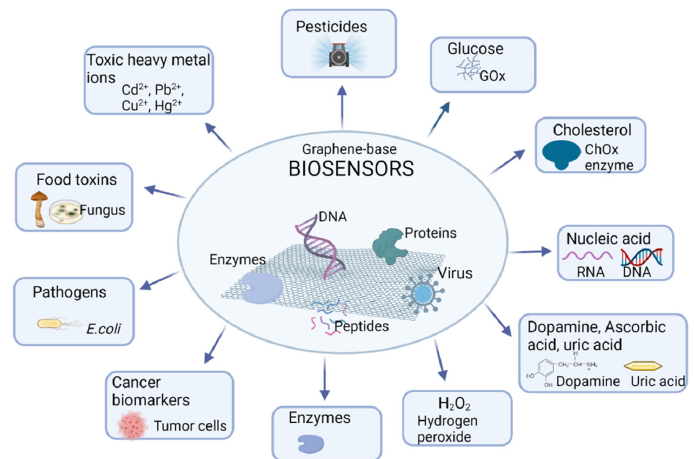
Figure 4. Applications of biosensors based on graphene and its derivatives. Created with BioRender.com (accessed on 2 March 2022).